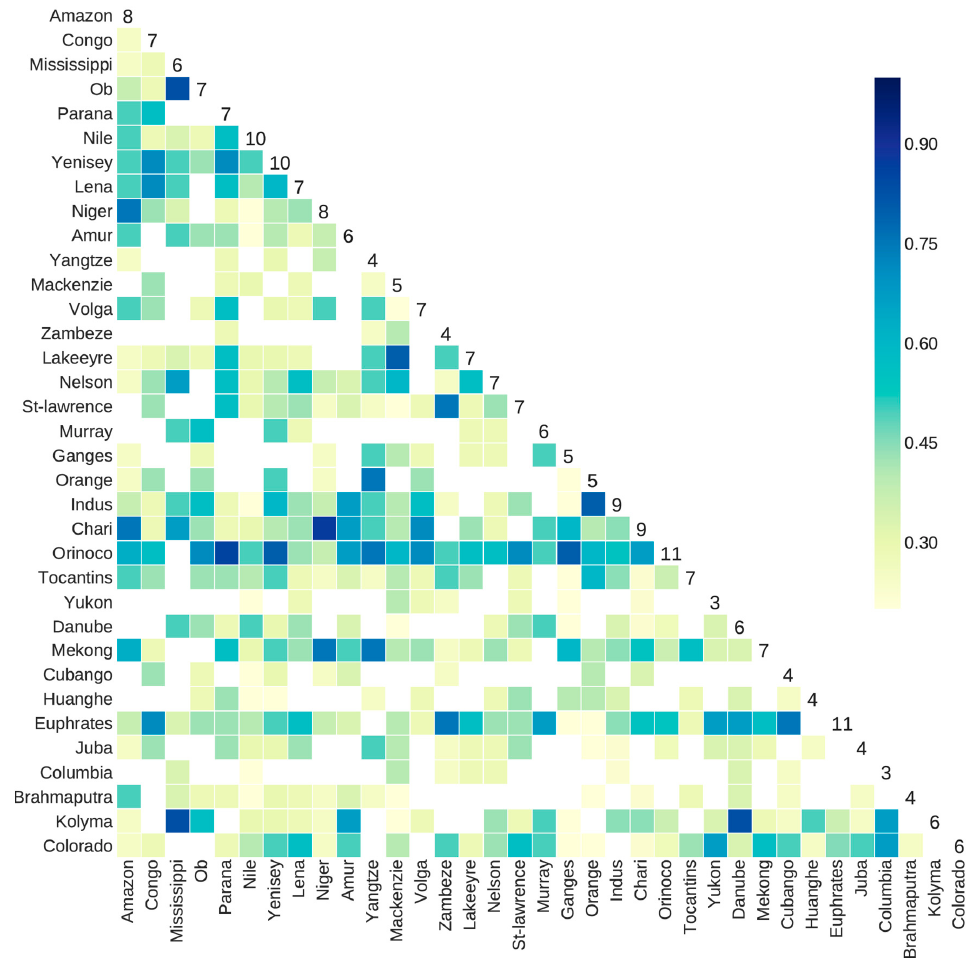
Figure 6. Heat map of BP coincidence among 35 river basins. The number of BPs for each basin is labeled on the diagonal axis. Each pixel on heat map represents pairwise basin event coincidence rate.